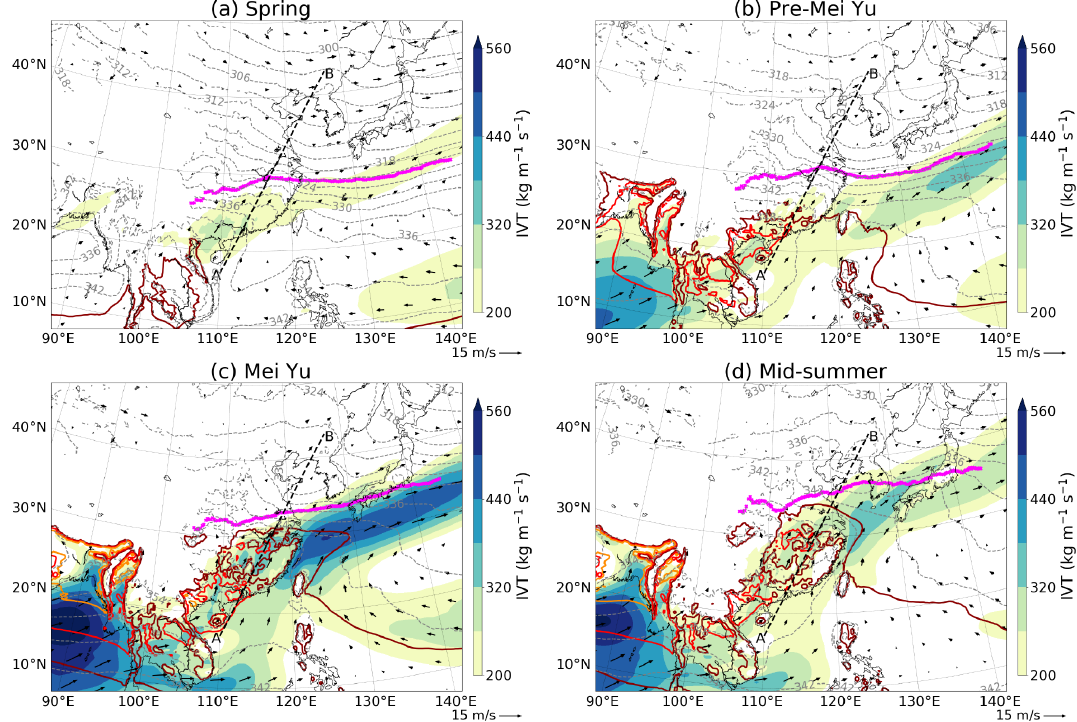
Figure 9. Dekadal mean of 500–1000hPa IVT (shading; kgm − 1 s − 1 ) and 500–1000hPa IWV (brown, red, and orange contours indicating 48, 53, and 58kgm − 2 , respectively), equivalent potential temperature at 850hPa (dashed grey lines; every 3K), and wind vectors at 850hPa (arrows; ms − 1 ). The magenta line indicates the climatology of the mean dekadal location of the EASMF at 850hPa. The AB dashed black line indicates the transect of the vertical cross-section in Fig. 10. The dekads representing the four stages of EASM progression (first dekad of May, first dekad of June, third dekad of June, second dekad of July, respectively) are selected according to Fig. 3. All values are masked out at levels below the ground. Data from ERA5 1979–2018